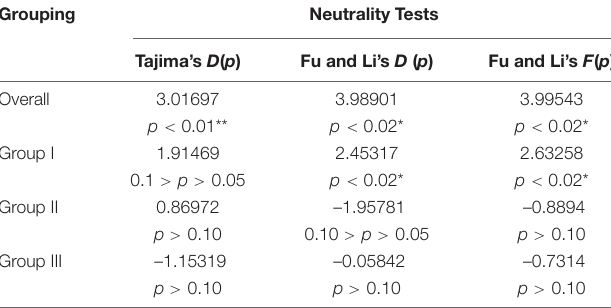
TABLE 4 | Neutrality tests of E. sibiricus populations based on SNPs